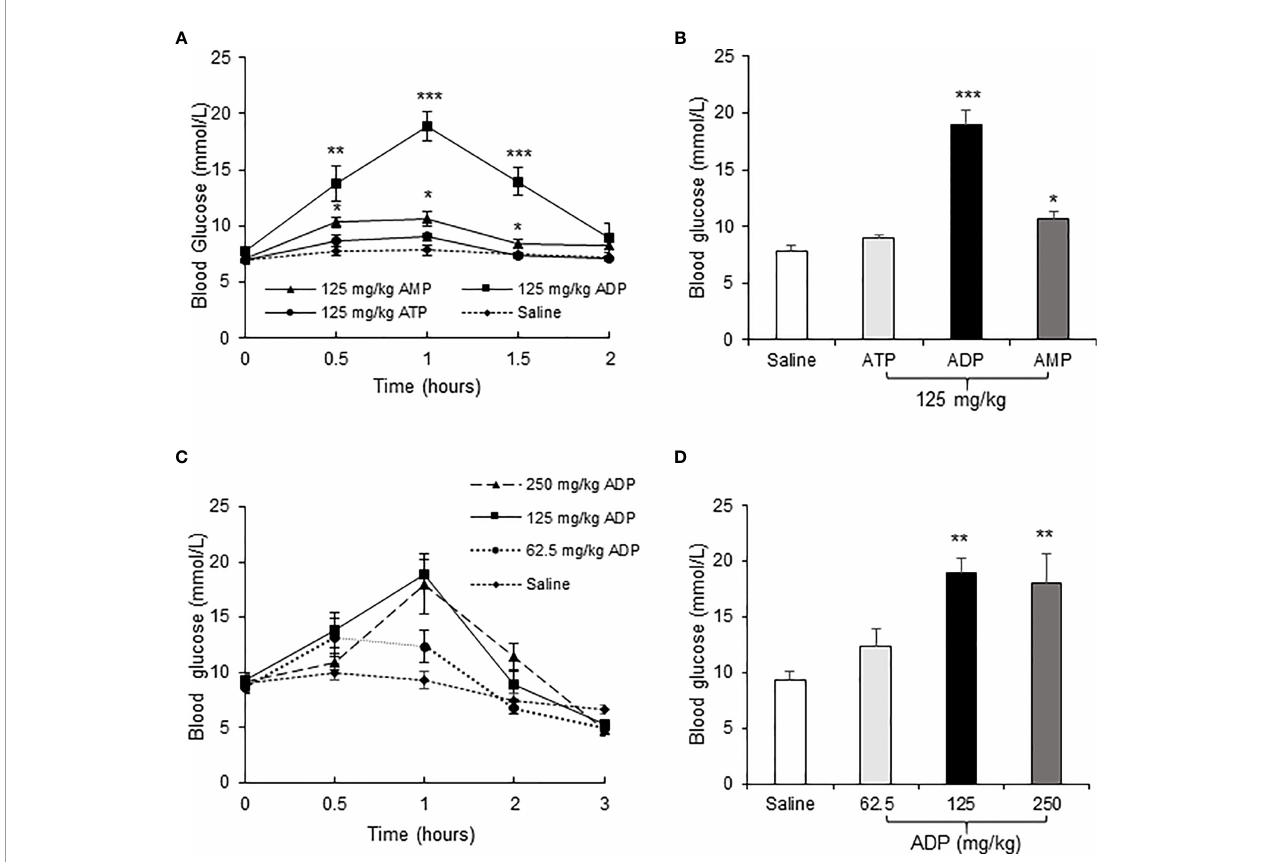
FIGURE 1 | ADP increased blood glucose in mice. (A) Comparison of the effects of ATP, ADP and AMP on induction of blood glucose. Blood glucose was determined in the tail vein blood at multiple time points (0, 0.5, 1, 1.5, 2h) after intraperitoneal (i.p.) injection of ATP, ADP, AMP (125 mg/kg, n=6). (B) Blood glucose at 1h after ATP, ADP, AMP injection. The data is derived from the fi gure (A) . (C) Dose effect of ADP. The blood glucose was determined at multiple time points (0, 0.5, 1, 2, 3h) at three dosages (62.5, 125, 250 mg/kg) of ADP, n=6). (D) Blood glucose at 1h after ADP injection. The data was derived from the fi gure (C) . The data in this fi gure represents mean ± SEM. *p < 0.05; **p < 0.01; ***p < 0.001 vs. the saline control